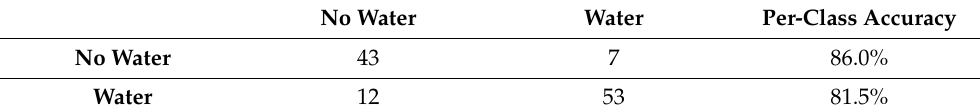
Table 5. Confusion matrix for the GoogleNet model.